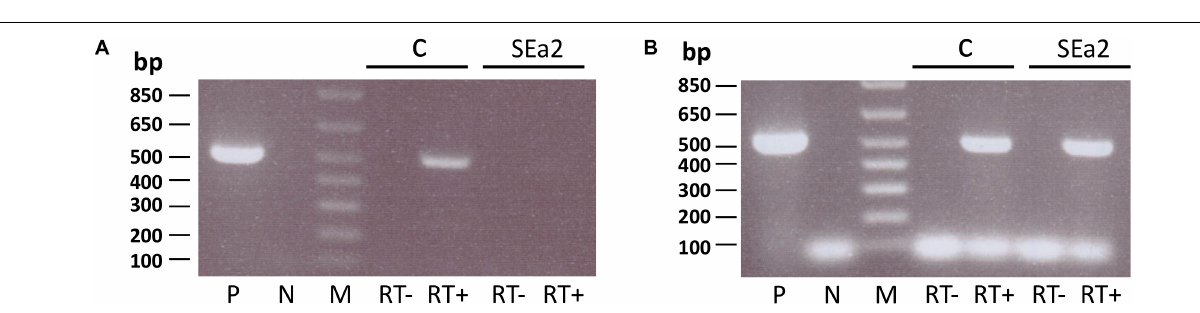
FIGURE 7 | trpS1 can be transcribed independently from endA . RNA was isolated from control cells (HV30 × pTA232, lanes c) and cells expressing crRNA SEa2 (HV30 × pTA232SEa2, lanes SEa2). RNAs were reverse transcribed using random hexamer primers. PCR was performed using primers spanning the overlapping region of endA and trpS1 (A) or a part of trpS1 (B) . PCR products were resolved on a 0.8% agarose gel. P: Amplification from HV30 gDNA as a PCR control. N: control without the addition of template DNA. M: 1 kb plus DNA ladder, with sizes given on the left. RT–, isolated RNA was added to exclude DNA contamination; RT+, cDNA template was added (from control cells or CRISPRi cells). Signals below 100 bp in panel B are derived from